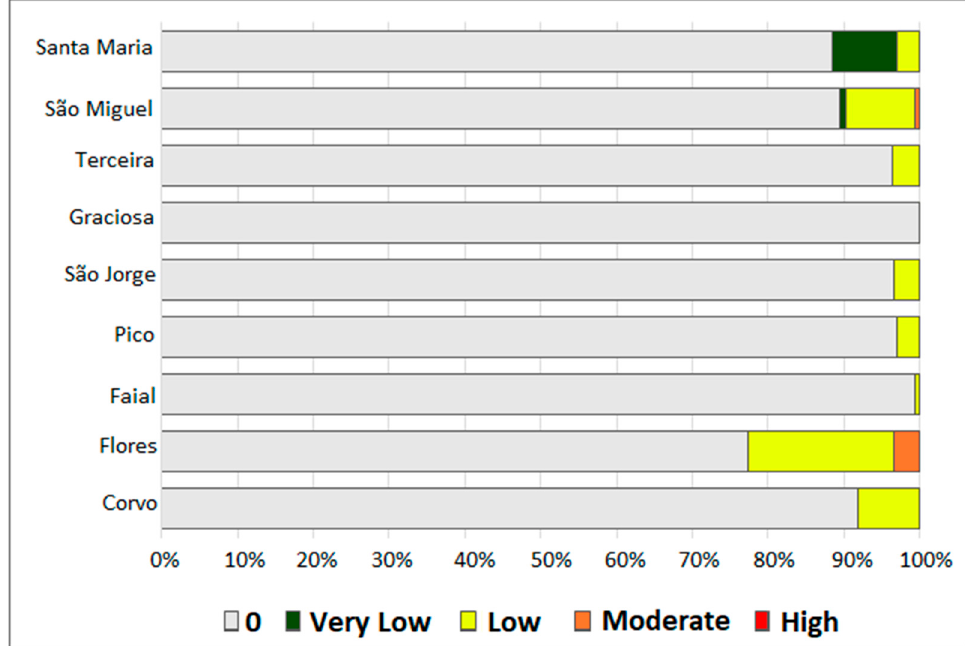
Figure 6. Fraction of the area of each island in the Azores occupied by the various classes of the ecosystem dependence index.